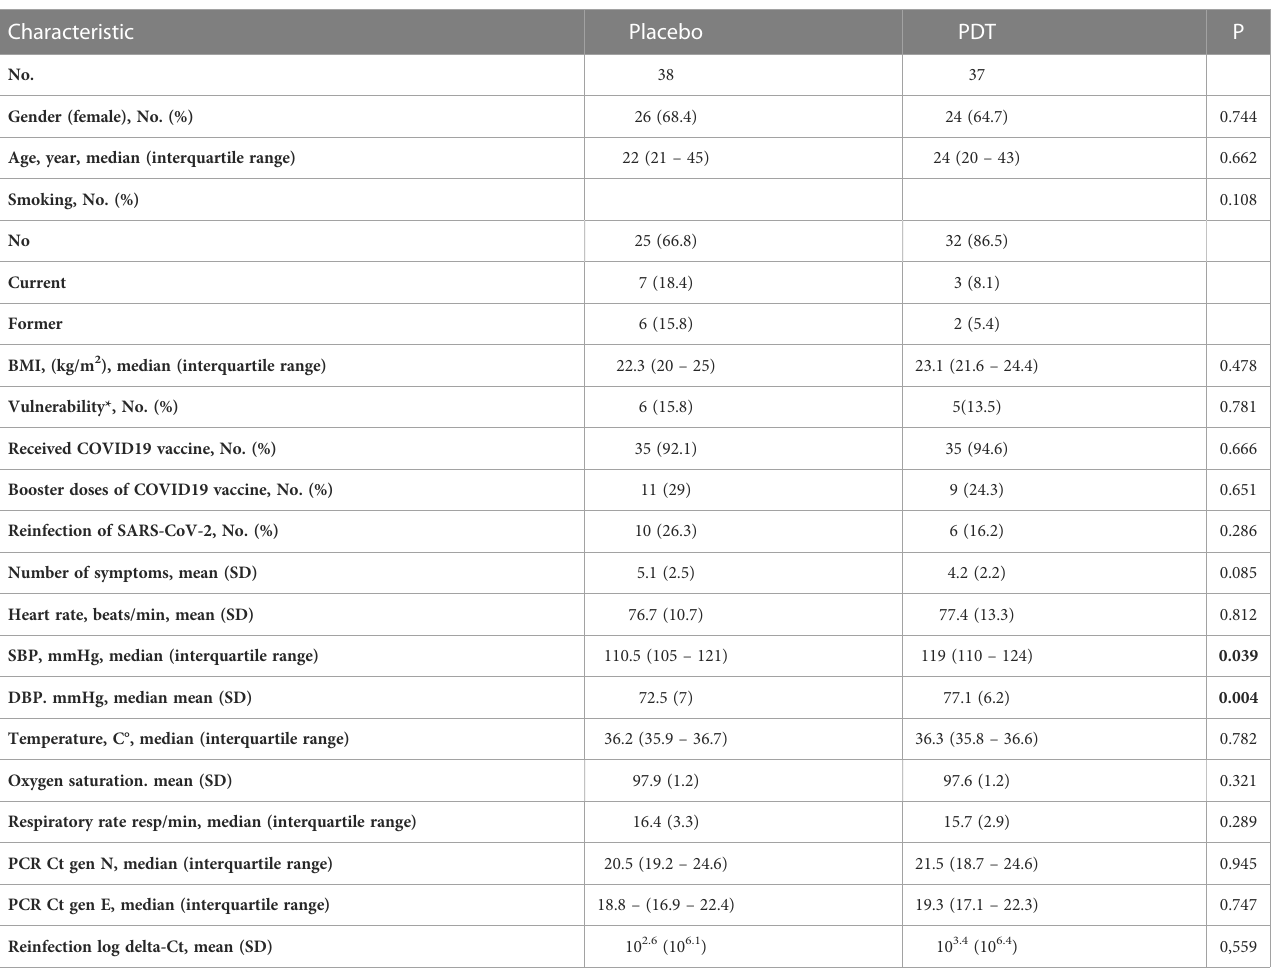
TABLE 1 Patients ’ baseline